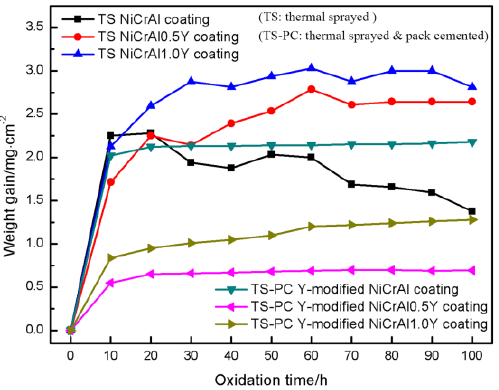
Figure 9. Comparison of oxidation weight gain between TS and TS-PC Y-modified coatings.